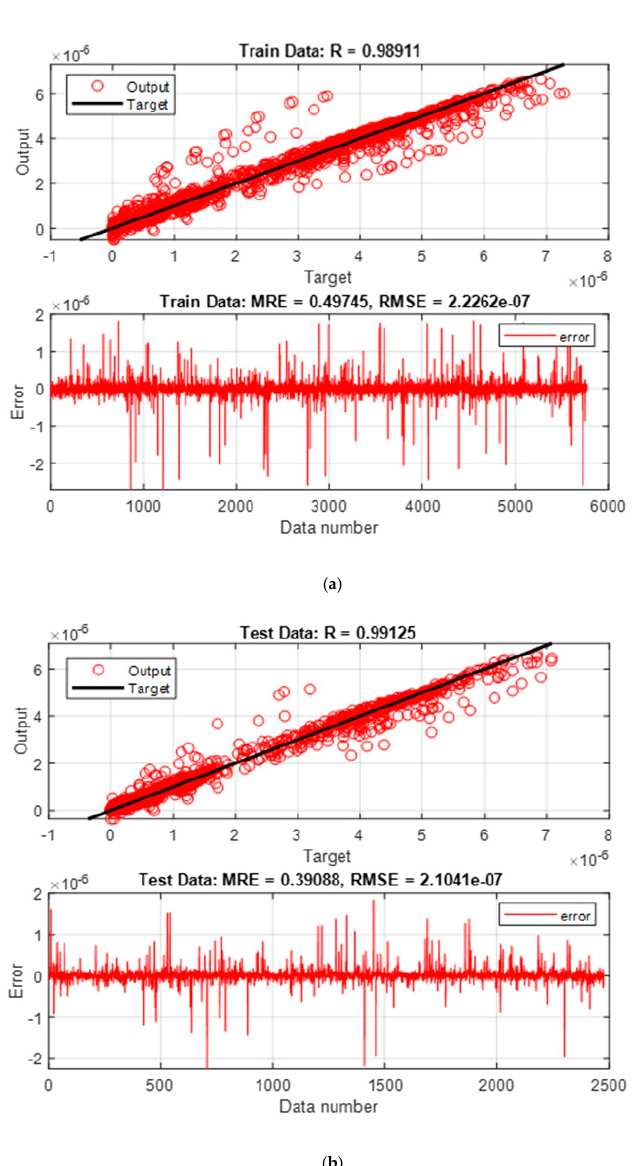
Figure 5. Regression and error diagram showing performance of RBF neural network for ( a ) training and ( b ) test